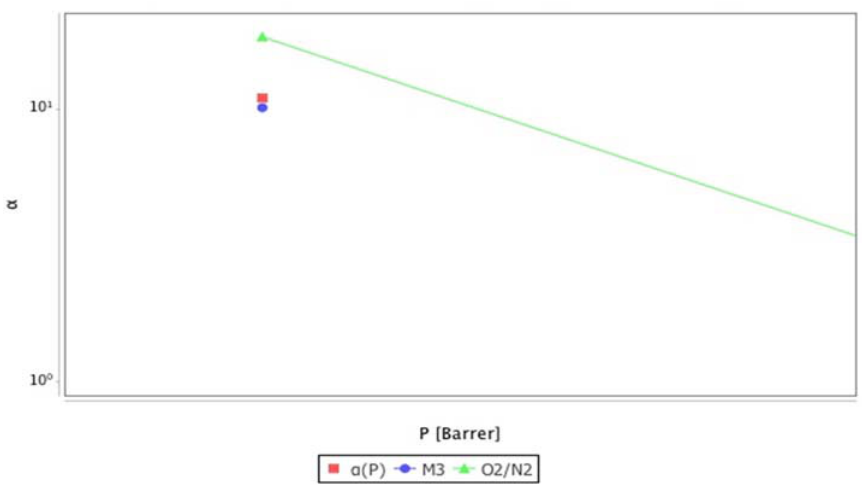
Figure 7. Comparison of experimental results (navy blue point) for the zeolite 4A-poly (vinyl acetate) mixed-matrix membranes with 3 different filler additions (M1, M2 and M3) with Maxwell theoretical results (red point) and their position relative to the Robeson upper bound line (green line). Table 3. Experimental [41] and theoretical MOT-predicted data for the zeolite 4A-poly (vinyl acetate) mixed-matrix